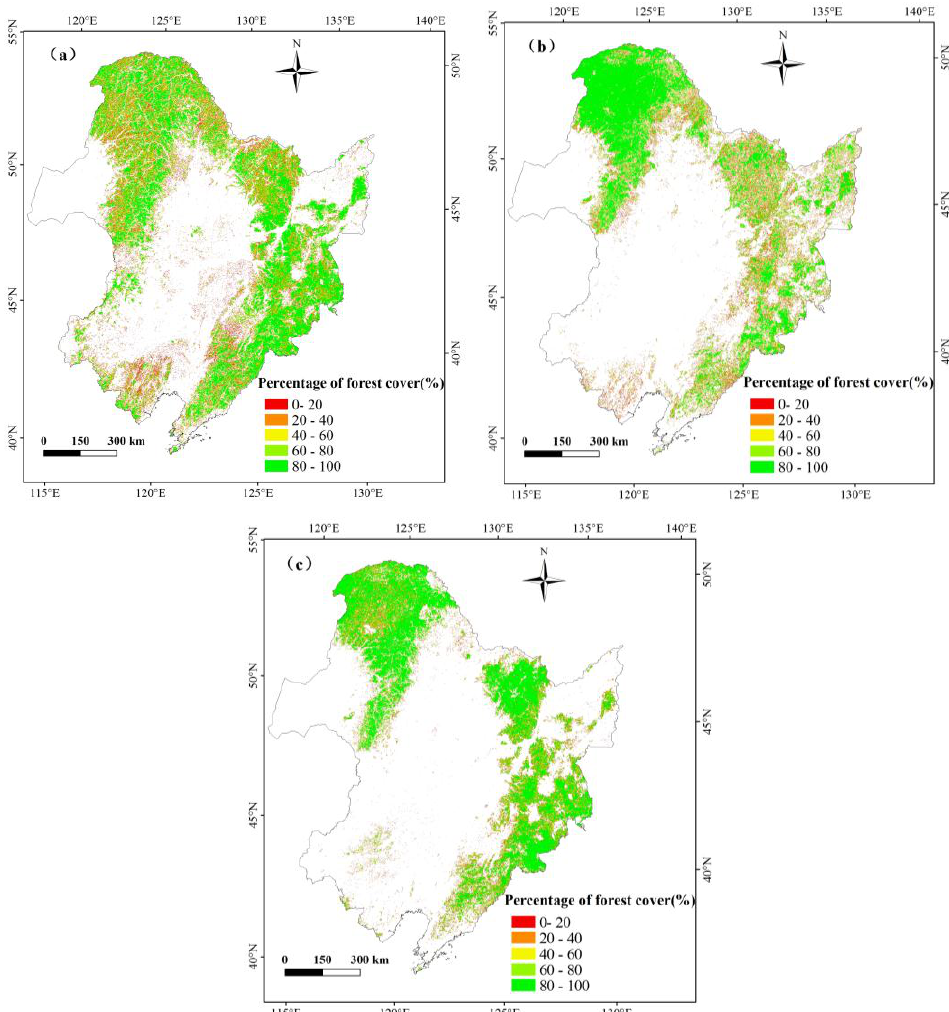
Figure 7. Forest cover percentage maps from HJ-1 2010 ( a ), GlobCover 2009 ( b ) and MCD12Q1 2009 ( c ) at a resolution of 1500 m.